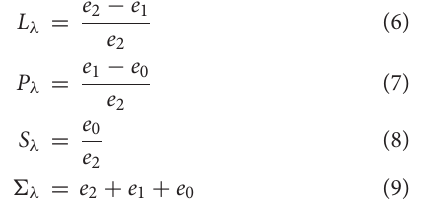
Frontiers in Built Environment |